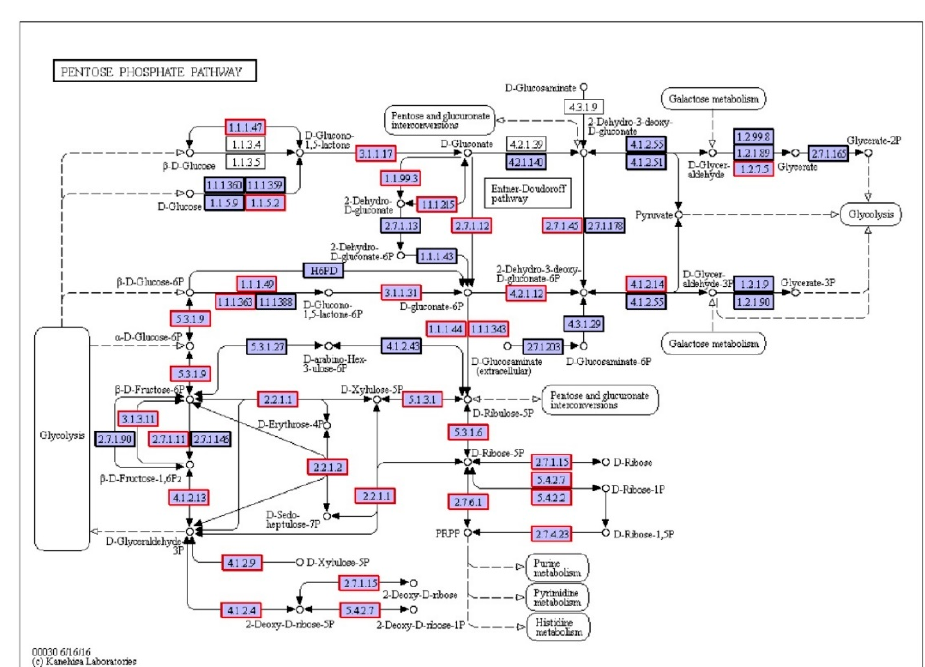
Figure 8. Pentose phosphate metabolic pathway.